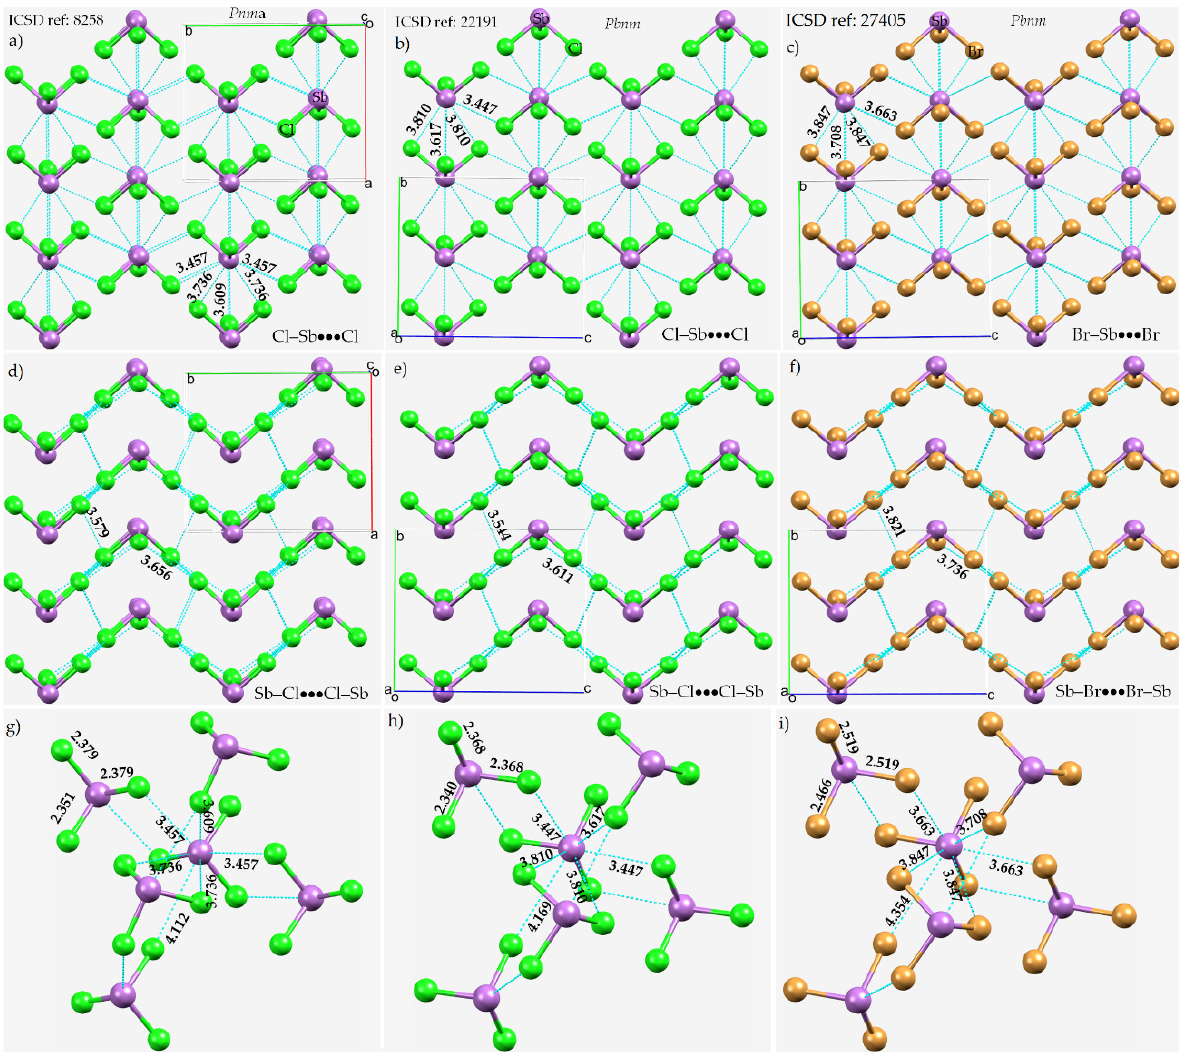
Figure 9. ( a , b ) The 2 × 2 extended structures of the SbCl 3 crystal in the space groups Pnma and Pbnm , respectively; ( c ) The 2 × 2 extended structure of SbBr 3 (space group Pbnm ). In all three cases, Cl–Sb···X (X = Cl, Br) intermolecular pnictogen bonding interactions are illustrated as dotted lines in cyan. ( d – f ) Representation of the structures of the same crystal systems, illustrating the presence of X···X (X = Cl, Br) intermolecular contacts. ( g – i ) Illustration of the local pnictogen bonding environ- ment around the Sb 3+ ion in SbX 3 . Selected bond distances are in Å and degrees, respectively.